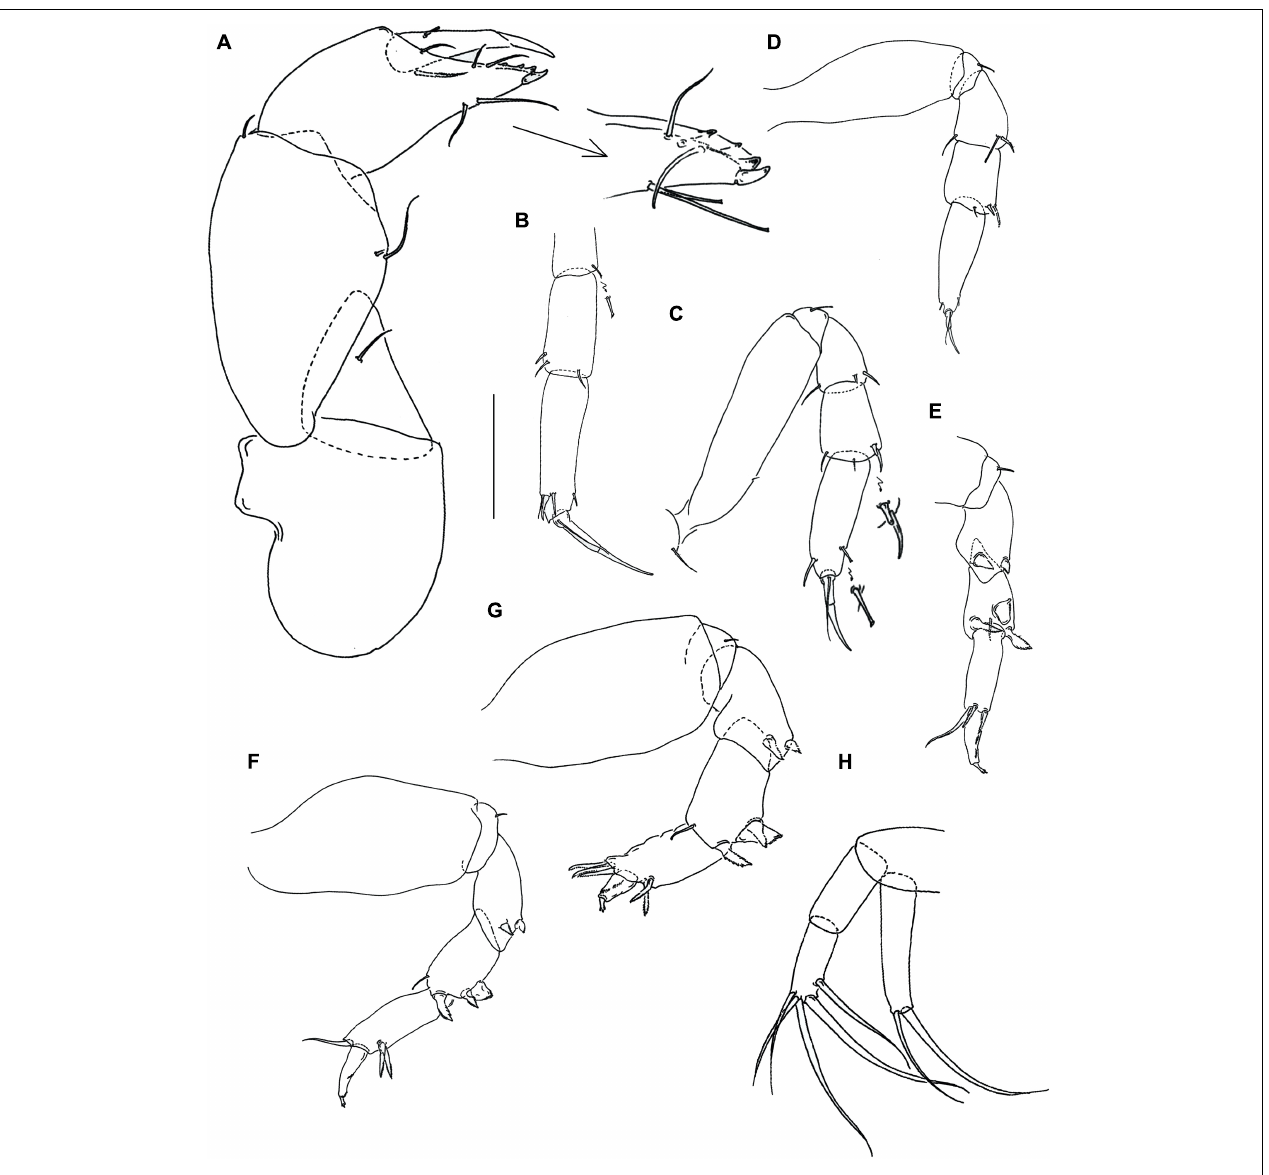
FIGURE 3 | Hamatipeda caipirinha n. sp. (MCZ 48366) (A) cheliped; (B) pereopod-1; (C) pereopod-2; (D) pereopod-3; (E) pereopod-4; (F) pereopod-5; (G) pereopod-6; (H) uropod. Scale: panels (A–H) = 0.1